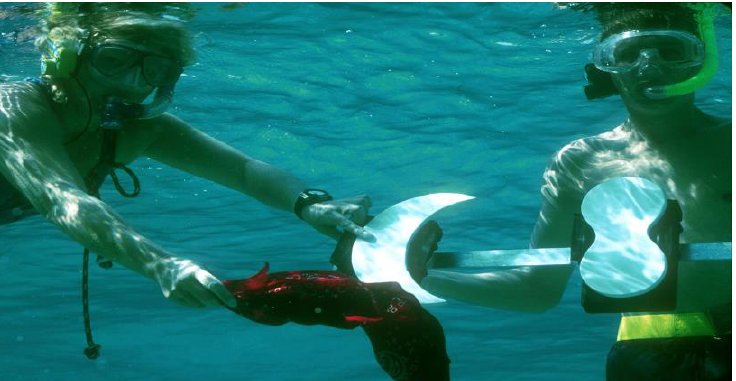
Figure 5. Underwater keyboard with visual and acoustic symbols used in the Bahamas with free-ranging Atlantic spotted dolphins. Picture used with permission – Wild Dolphin